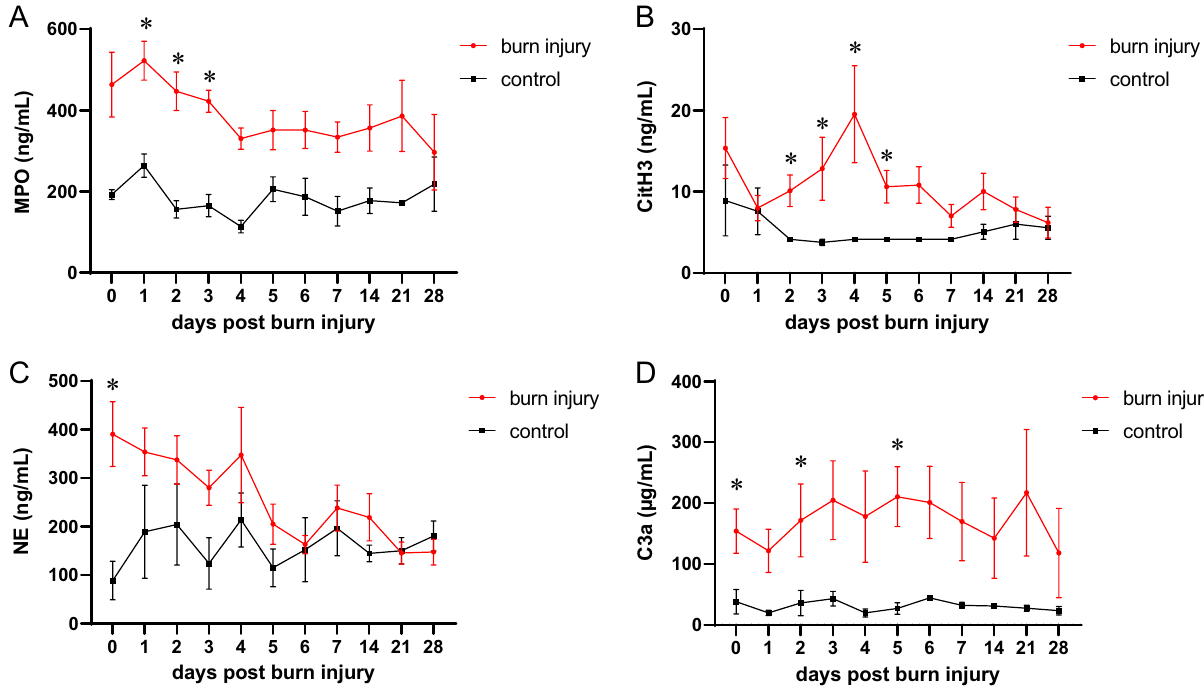
Figure 1. Elevated neutrophil-derived factors and C3a in burn sera. Systemic levels of ( A ) MPO, ( B ) CitH3, ( C ) NE, and ( D ) C3a were quantified in sera of burn victims (n = 8–19) and healthy controls (n = 4–6) up to 4 weeks post injury. Data were compared by mixed effects analysis and Sidak’s multiple comparisons post hoc test. Data are presented as means ± s.e.m. Asterisks indicate p values <